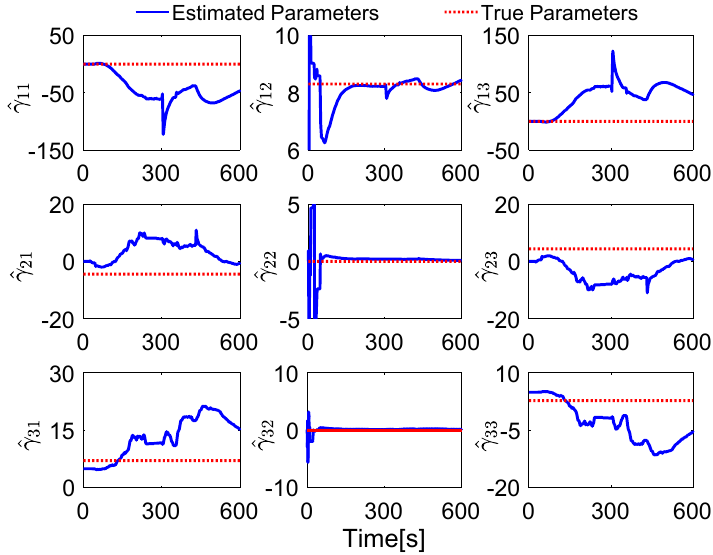
Figure 10. Comparison between estimated parameters and true parameters.